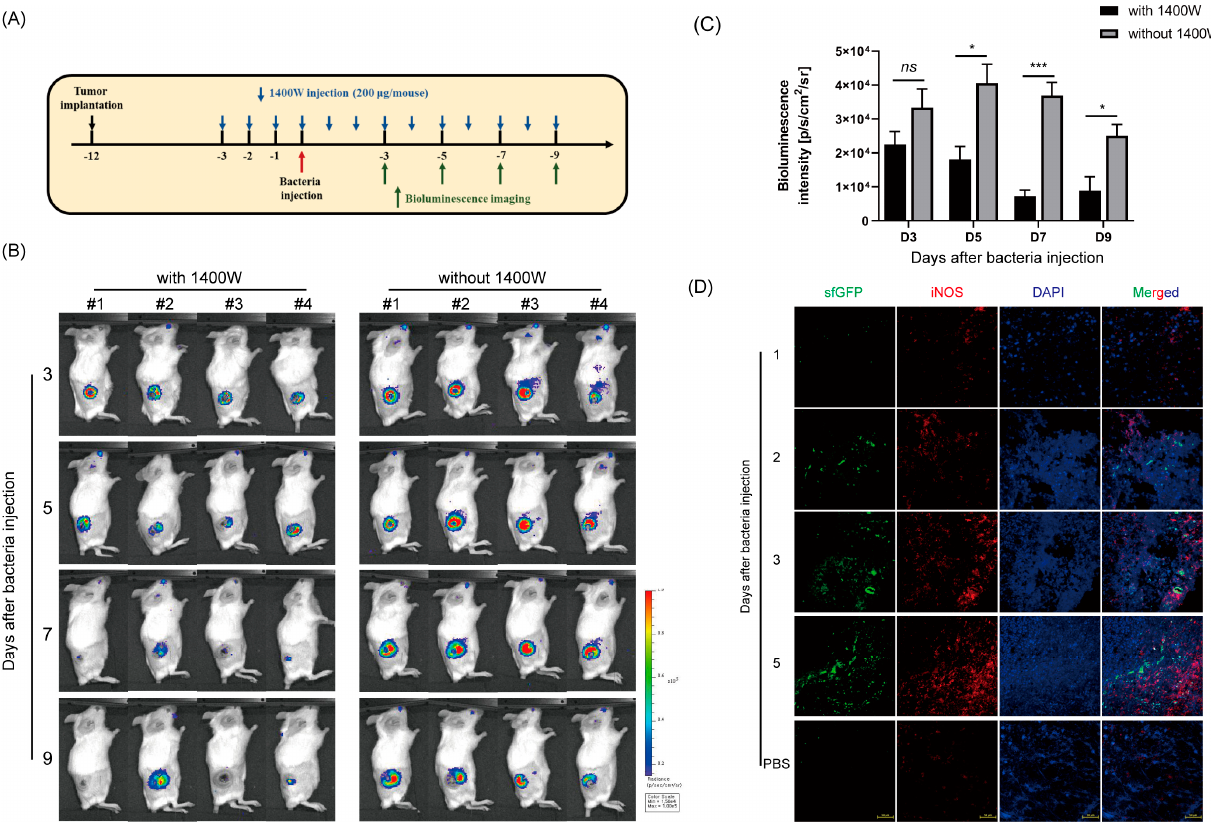
Figure 7. In vivo NO − specific switch activation. ( A ) Scheme of the experiment. CT26 tumor-bearing mice were intraperitoneally administered 1400 W daily, starting 3 days before SL . pNASR injection until the end of the experiment. Bioluminescence imaging was performed 3, 5, 7, and 9 days after administration of SL . pNASR. ( B ) Bioluminescence images of CT26 tumor-bearing mice in the pres- ence or absence of 1400 W treatment 3, 5, 7, and 9 days after injection of 1 × 10 7 CFUs SL . pNASR. ( C ) Quantification of bioluminescence signals in the tumor tissues. Values represent the mean ± SEM. * p < 0.05, ** p < 0.01, and *** p < 0.001; ns, not significant by Student’s t -tests. ( D ) Immunoflu- orescence staining of iNOS and sfGFP expression in CT-26 tumor tissues on the indicated days after SL . pNASGFP injection. Switch activation was indicated by the expression of sfGFP (green), sections were stained with anti-iNOS antibody (red), and nuclei were stained with DAPI (blue). Merged images are also shown (merged). Scale bar, 50 μ m. Data are representative of three independent experiments.